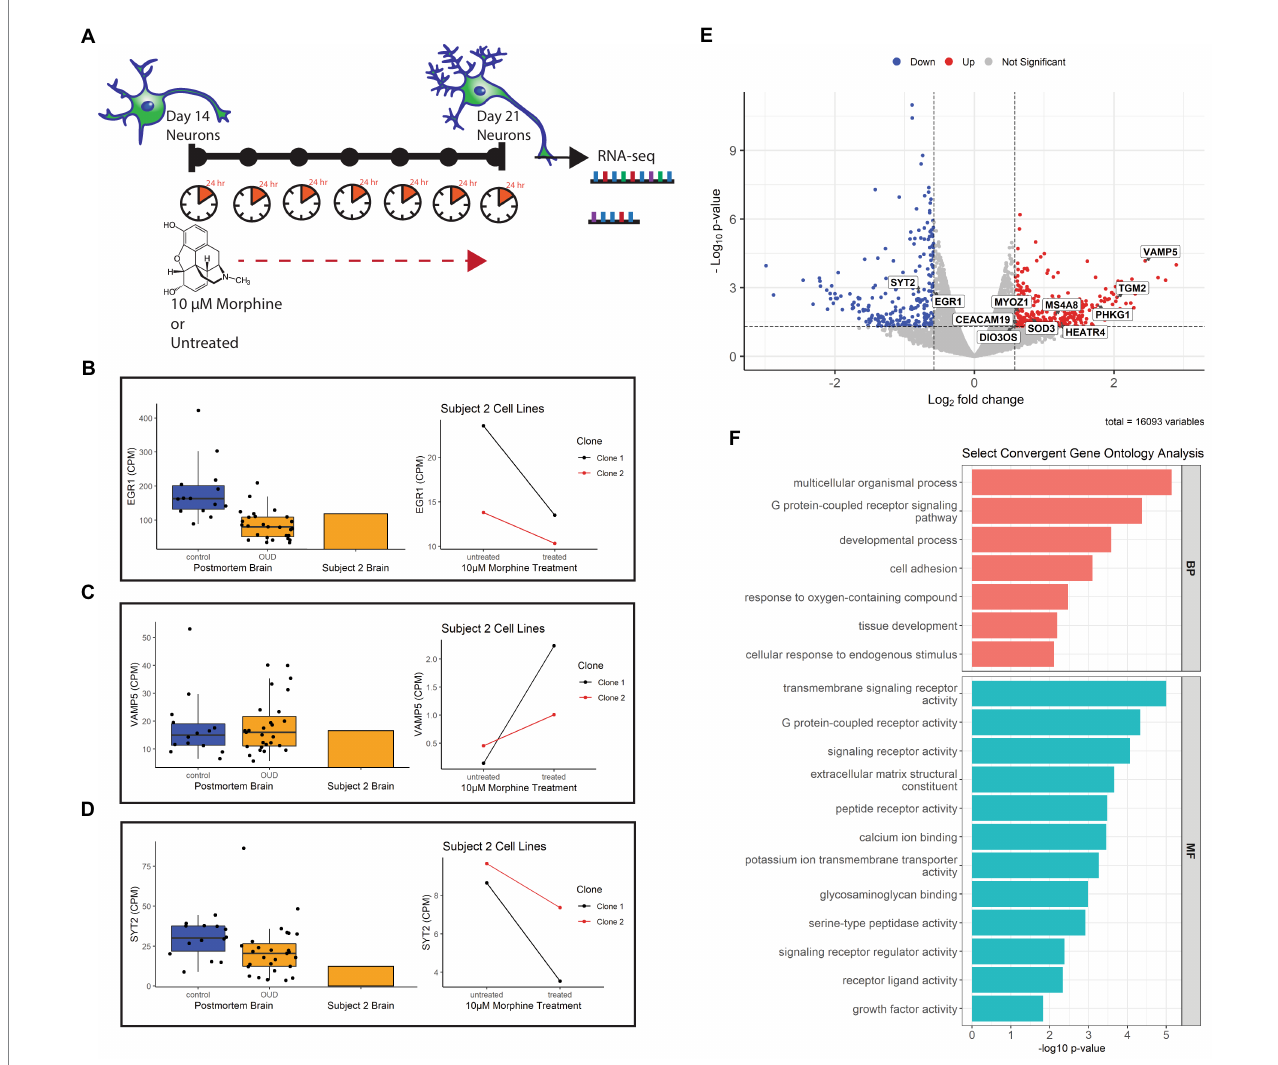
FIGURE 6 Gene expression of morphine-treated cell lines. (A) Morphine treatment paradigm of Subject 2 neuron cell lines. Cells were treated with 10 μ M morphine or left untreated for 7 days, between day 14 and 21 of differentiation. RNA was collected from treated and untreated cells at 21 days of differentiation. (B) Volcano plot showing differentially expressed genes in the morphine-treated cell model. Genes convergent with those in postmortem brain of OUD subjects are labeled. For data integration with postmortem brain OUD gene signatures, a nominal value of p cutoff of 0.05 and absolute FC of at least 1.5 (depicted as log2FC = ± 0.58 in volcano plot) was used to determine significance. (C–E) Boxplots (left) of postmortem brain gene expression (CPM) compared with barplot (middle) of postmortem brain from Subject 2. Line plots (right) show gene expression changes per neuron clonal cell line after morphine treatment. (F) Selected convergent biological processes (BP) and molecular functions (MF) perturbed in both postmortem brain of OUD subjects and morphine-treated cell